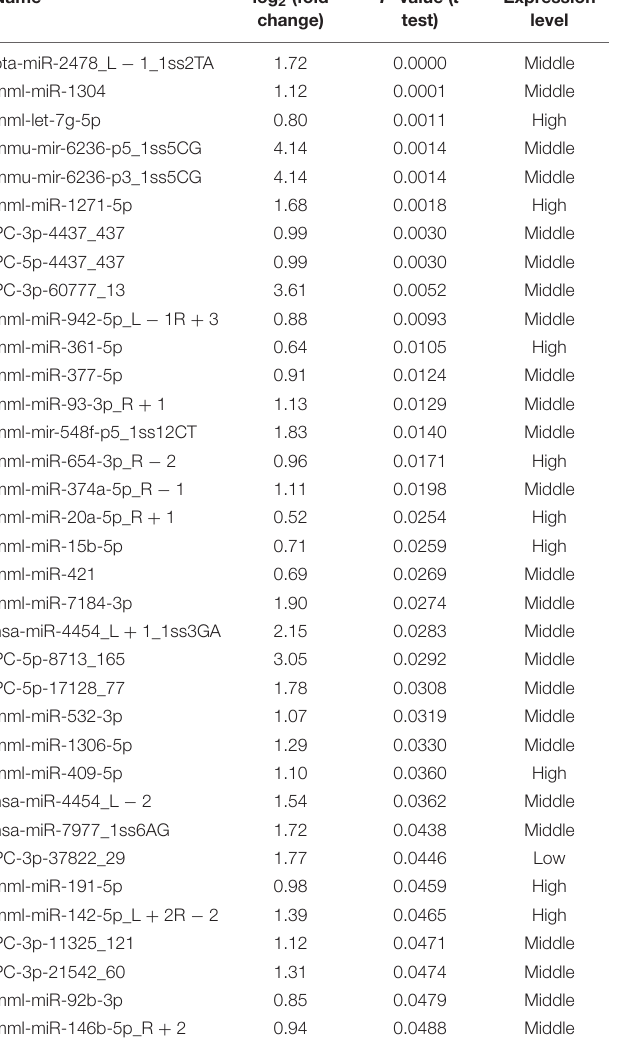
TABLE 1 | Summary information of upregulated miRs.